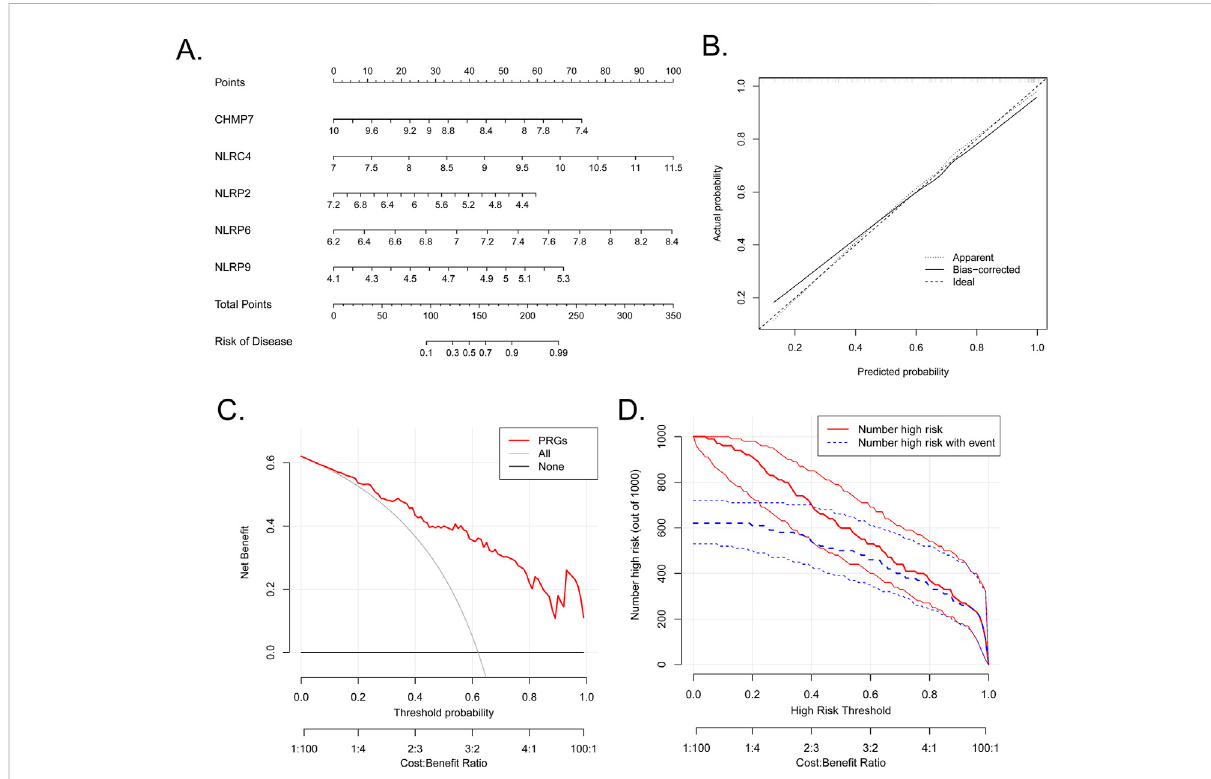
FIGURE 4 Establishment of the nomogram. (A) Establishment of a nomogram based on the fi ve biomarkers. (B) Calibration curve revealing the predictive ability of the nomogram. (C) The nomogram may be used to make decisions that favor BPD patients. (D) Clinical impact curve revealing the clinical impact of the nomogram.